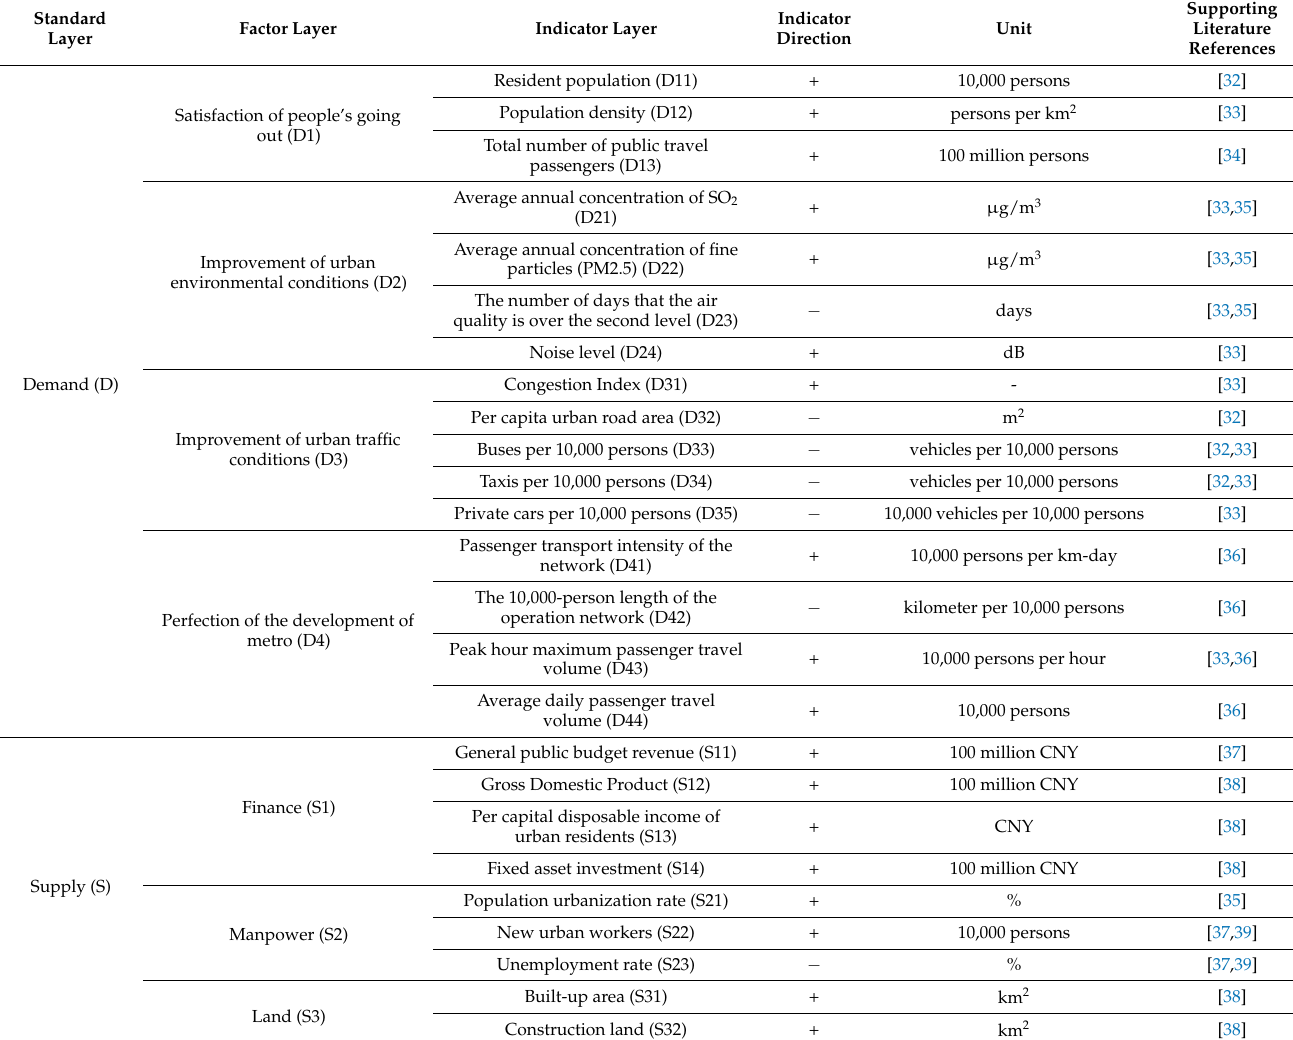
Table 1. Comprehensive evaluation indicator system of metro development